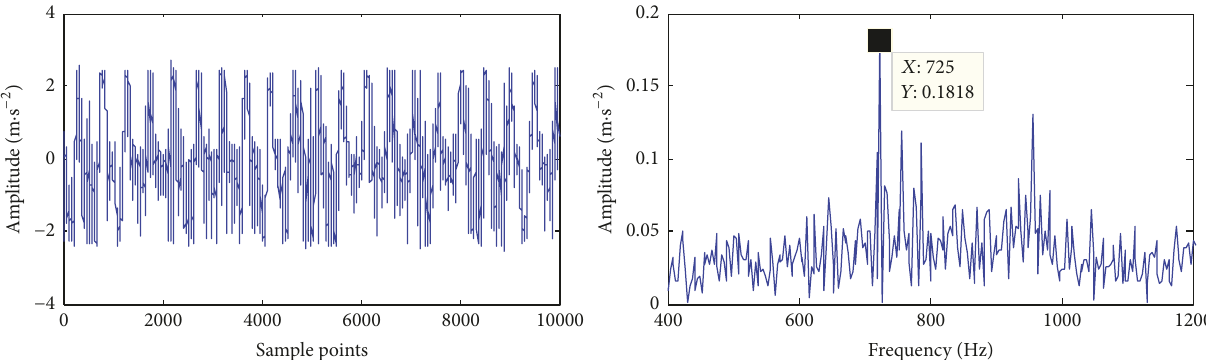
Figure 19: The output signal of experimental data through the rescaling multistable system.